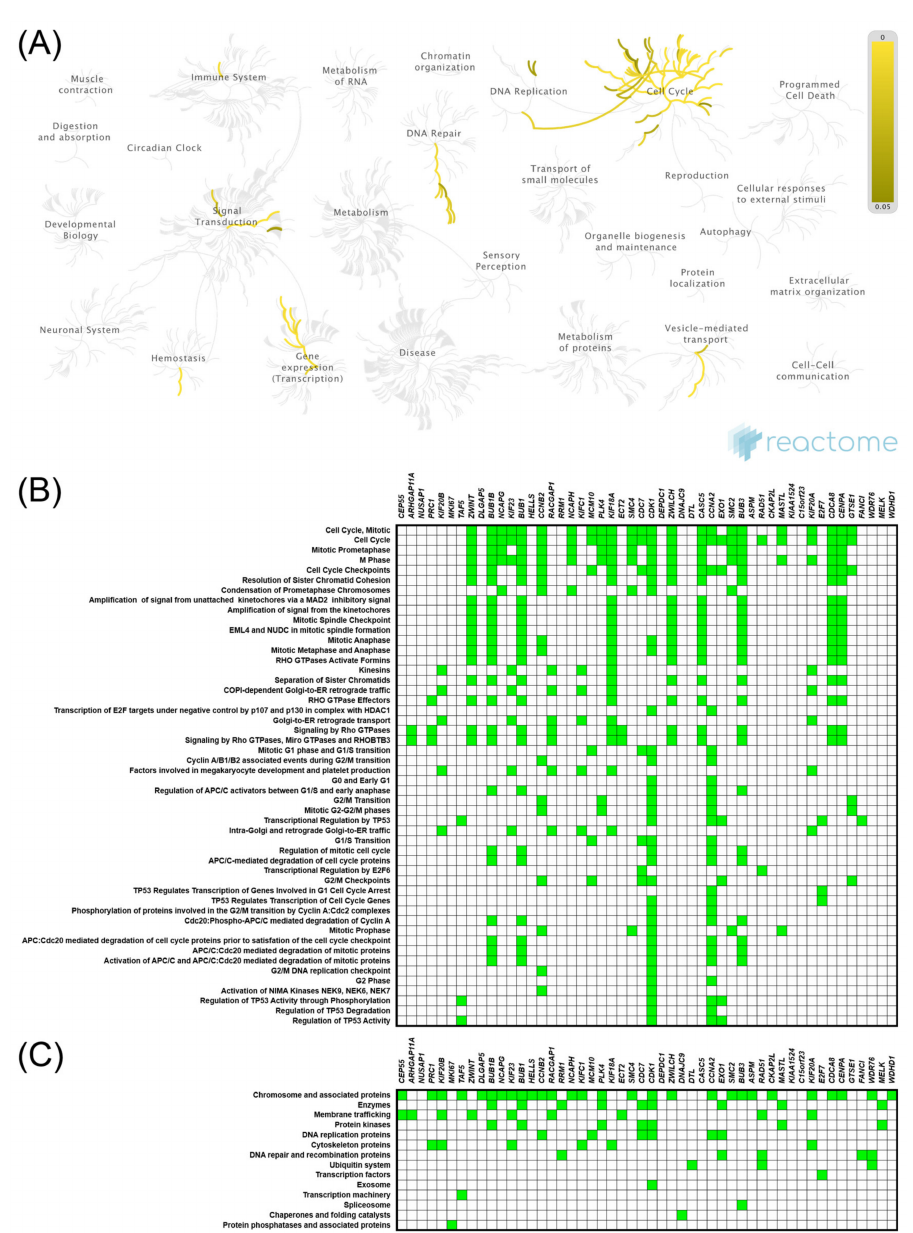
Figure 4. Functional enrichment analysis based on the TCGA dataset and UALCAN web tool. The top 50 genes and reactome pathways positively correlated with KIF11 expression ( A , B ); BRITE functional hierarchies for the top 50 genes that were co-upregulated with KIF11 ( C